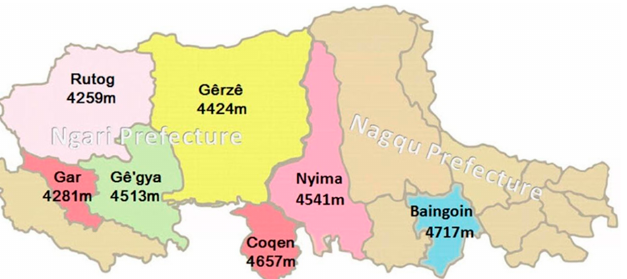
Figure 1. Distribution of the Northwestern Tibetan cashmere goat population, showing different counties and their altitudes.